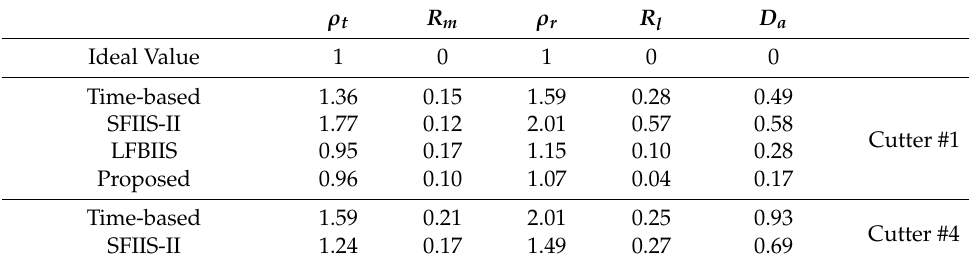
Table 5. Results of performance metrics for the PHM2010